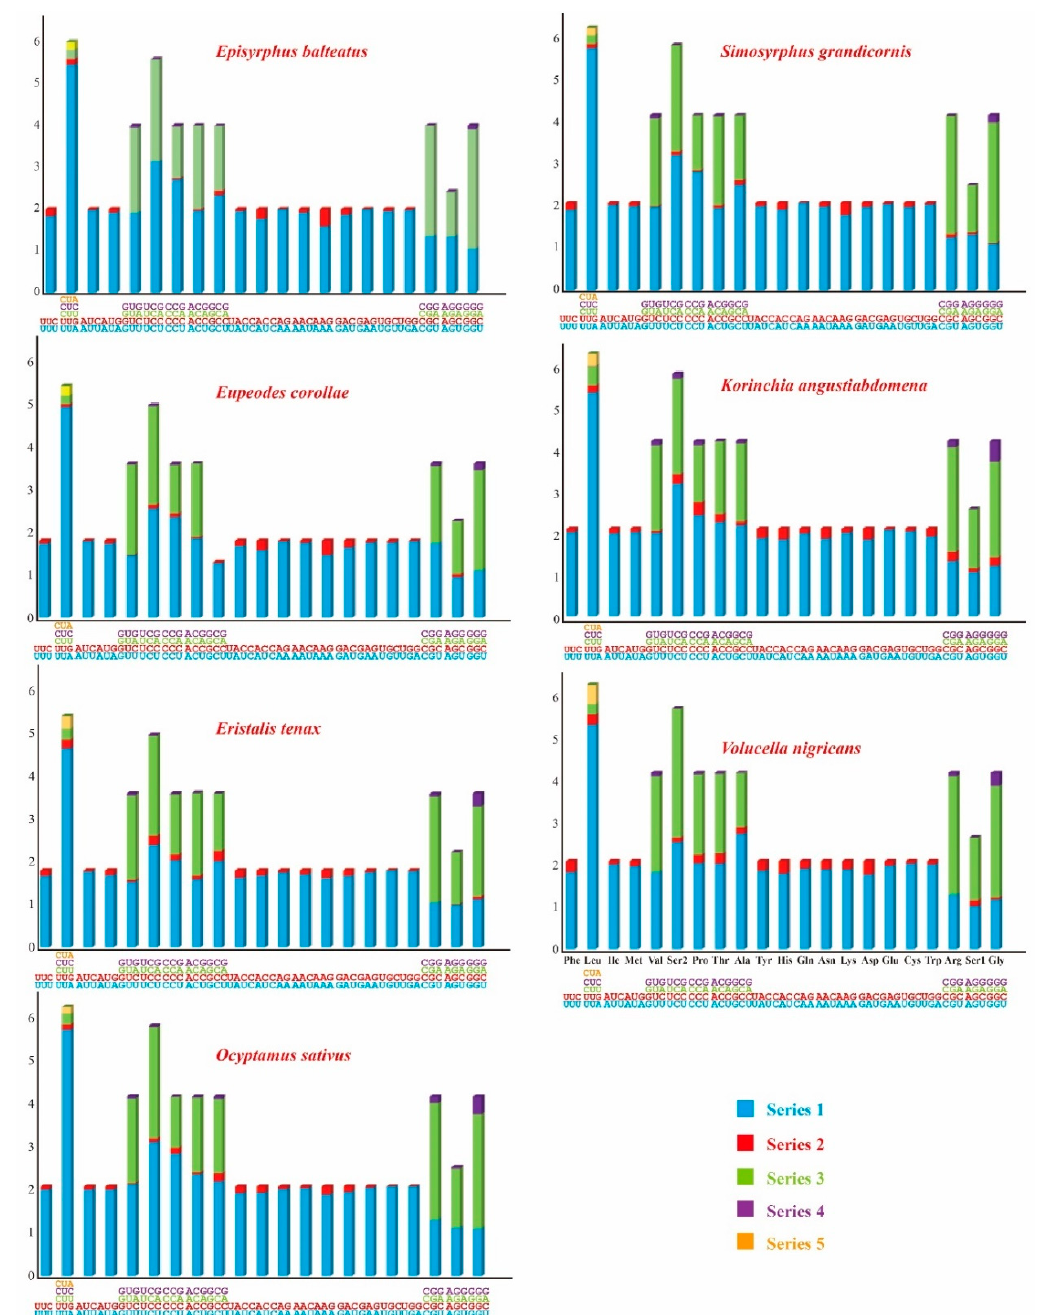
Figure 3. Relative synonymous codon usage (RSCU) in the mitogenomes of seven Syrphidae. The stop codon is not given. The di ff erent colors in the column chart represent the codon families corresponding to below amino acids, and the seven Syrphidae use consistent colors to represent the same codon